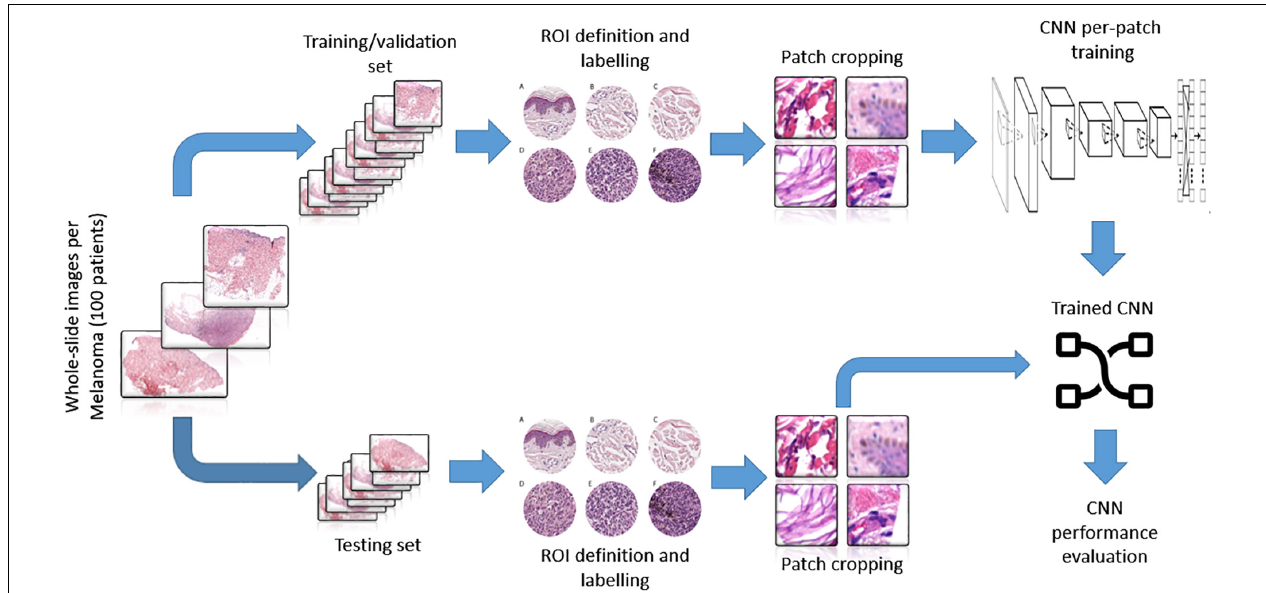
FIGURE 3 | Representative scheme of the methodological pipeline. The whole slide images of melanoma from 100 patients were split in training/validation and testing datasets that are disjointed during the process. ROIs of normal and pathological tissues were extracted from the two datasets and labeled. (A–C) Healthy tissue, (D–F) invasive cutaneous melanoma. Each ROI was tiled in 299 × 299 pixel patches. The patches of training/validation sets were used for the training of CNN. Finally, the performance indices of classification were estimated by applying the trained CNN to the testing set.